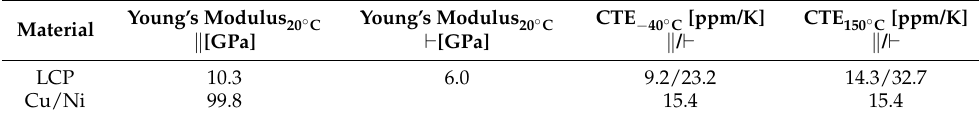
Figure 6. Boundary conditions of simulation for ( a ) flexural fatigue test and ( b ) thermal shock test. Table 2. Materials’ data, on which the simulations are based